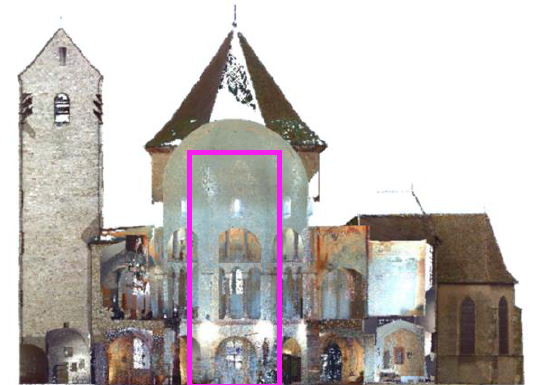
Figure 5. Point cloud of the expected sectional view (along west/east axis, seen from the south)